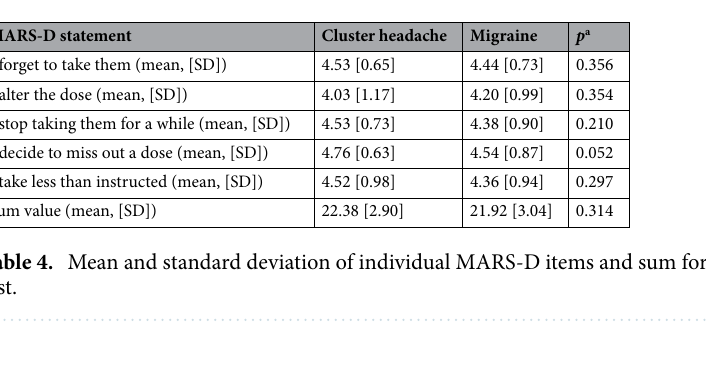
MARS-D score Patients with score 25 n(%) Table 5. Patients with maximum MARS-D point score. a Pearson’s chi-squared test.